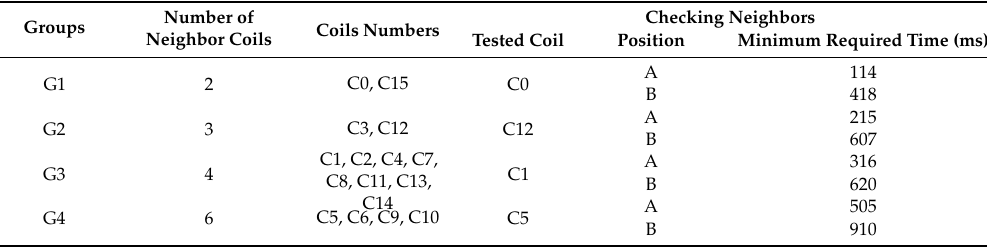
Table 4. Groups of coils according to their neighbor’s number.